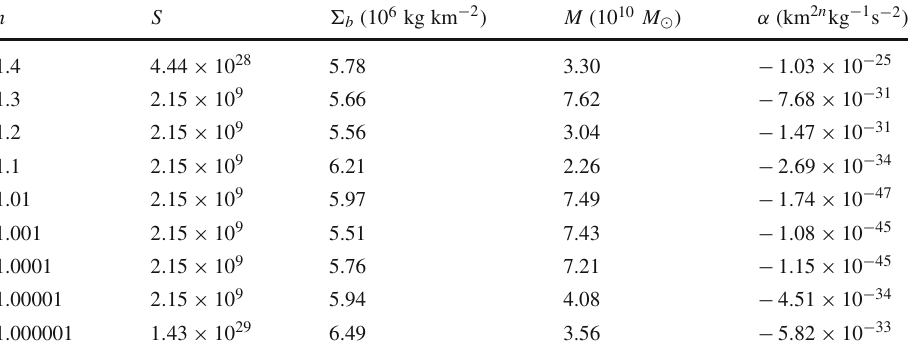
Table 3 Fit of bulge surface n S (cid:4) b (10 6 kg km − 2 ) M (10 10 M (cid:3) ) α (km 2 n kg − 1 s − 2 ) mass density, disk mass and f ( T ) coupling constant values